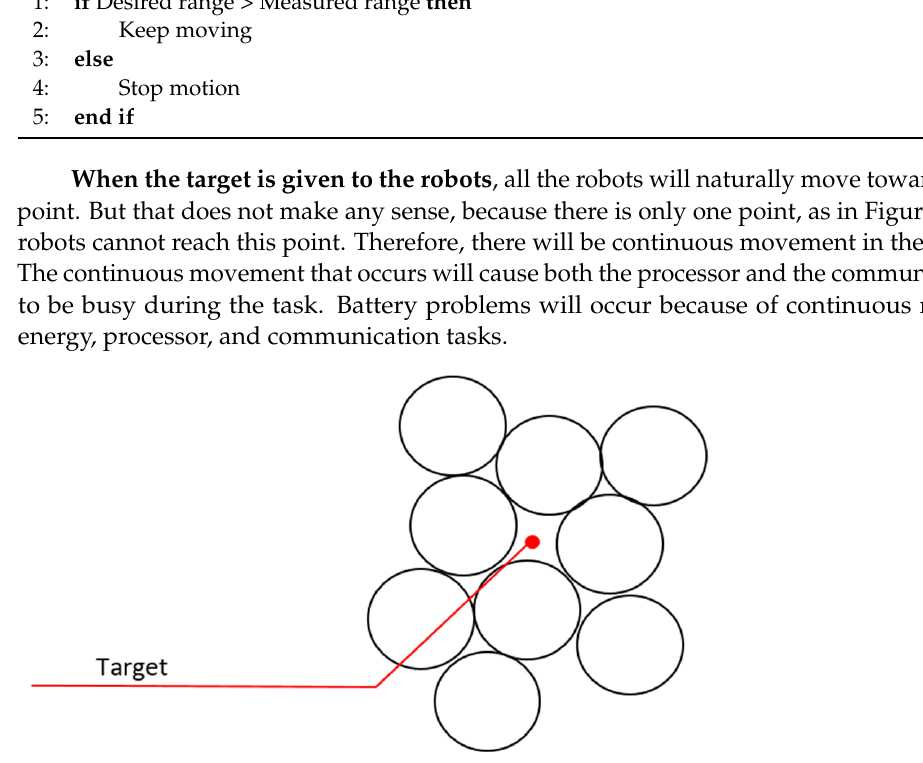
Algorithm 4 Solution: When the target is given to the